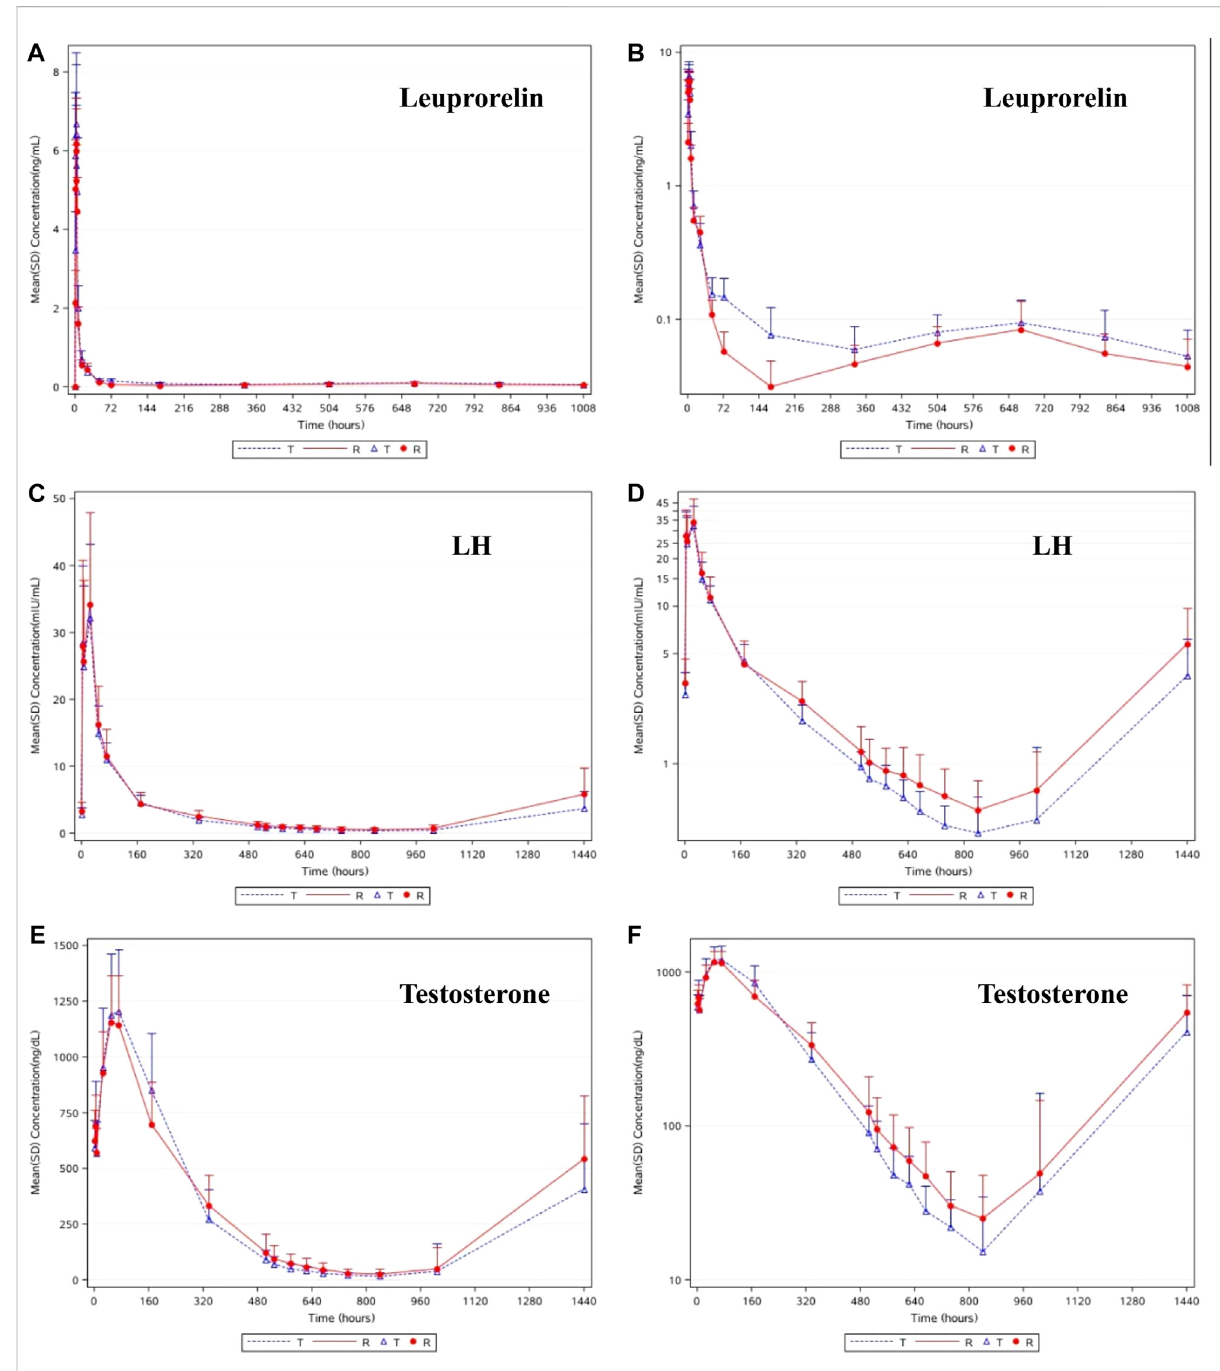
FIGURE 2 Thelinear (A) andsemilog (B) ofmeanconcentrationsofleuprolide-timecurveinserum.Thelinear (C) andsemilog (D) ofmeanconcentrations of LH-time curve in serum. The linear (E) and semilog (F) of median concentrations of testosterone-time curve in